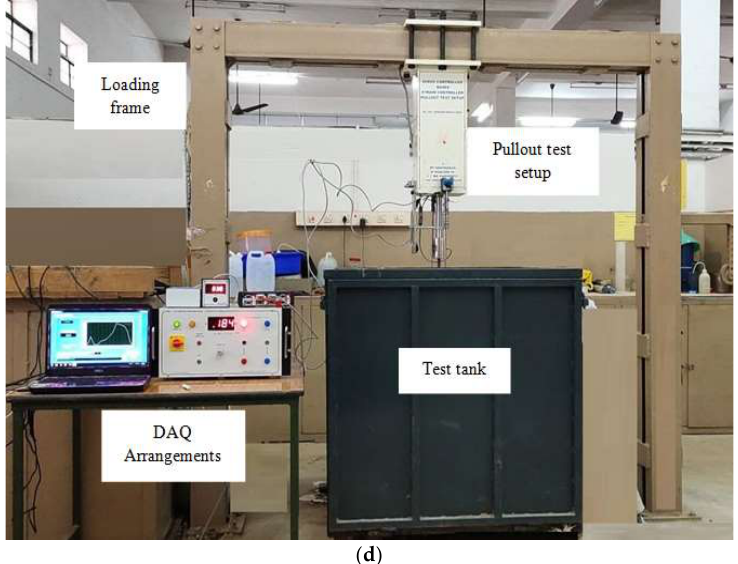
Figure 6. ( a ) Schematic view of the experimental setup (Uplift loading); ( b ) Data Acquisition Ar- rangements (DAQ); ( c ) Completed test installation of Helical pile and LVDT arrangements prior to Loading; and ( d ) Pictorial view of the Experimental Test Setup-Uplift loading.